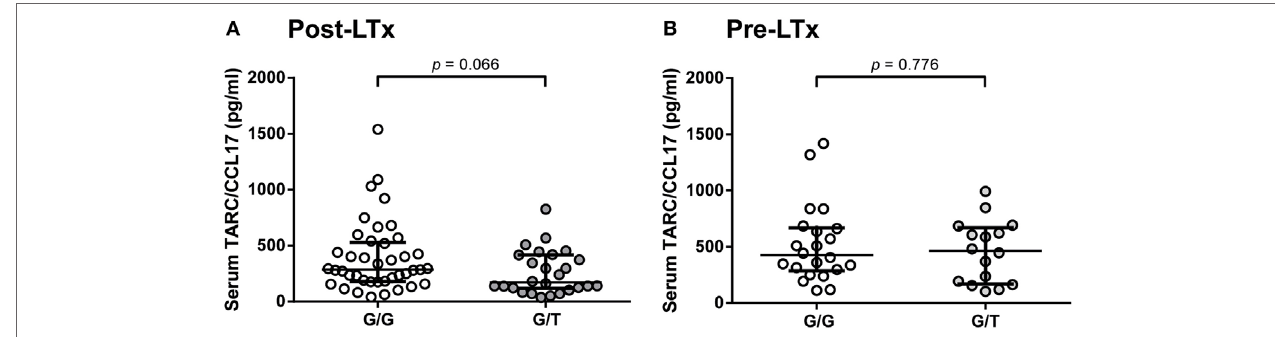
FigUre 1 | Donor rs223899 correlates with serum thymus and activation-regulated chemokine (TARC/CCL17) concentrations post-lung transplantation (LTx) LTx but not pre-LTx. (a) Serum TARC/CCL17 levels were measured in LTx patients 1 month after LTx stratified for the configuration of donor single-nucleotide polymorphism (SNP) rs223899 (homozygous, G/G, 286.0 pg/ml vs. heterozygous, G/T 170.5 pg/ml). A trend toward significance ( p = 0.066) was observed with increased TARC/CCL17 serum concentrations in patients who received a graft genotyped homozygous for SNP position rs223899. Non-Gaussian distribution, median ± interquartile range, Mann–Whitney test, homozygous n = 41, heterozygous n = 26. (b) Serum TARC/CCL17 levels were also assessed pre-LTx in patients based on serum availability. No differences in serum TARC/CCL17 could be observed when patients were stratified for the respective rs223899 SNP genotype. Non-Gaussian distribution, median ± interquartile range, Mann–Whitney test, homozygous n = 22, heterozygous n = 16.